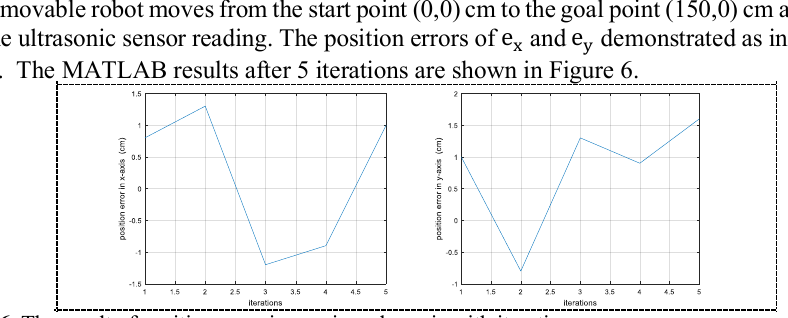
Fig. 6. The result of position error in x-axis and y-axis with iterations